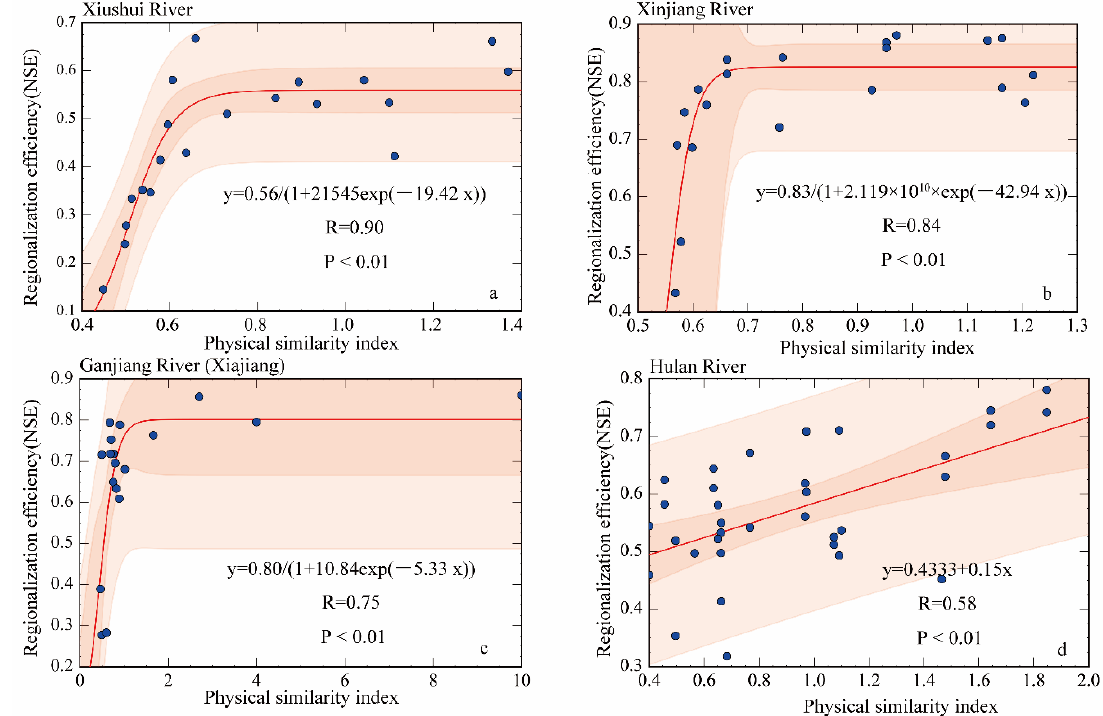
Figure 8. Correlation diagram of physical similarity and parameter transfer efficiency in the Hulan River Basin and the Poyang Lake Basin ( a : Xiushui River; b :Xinjiang River; c : Gangjiang River (Xiajiang station); d : Hulan River).